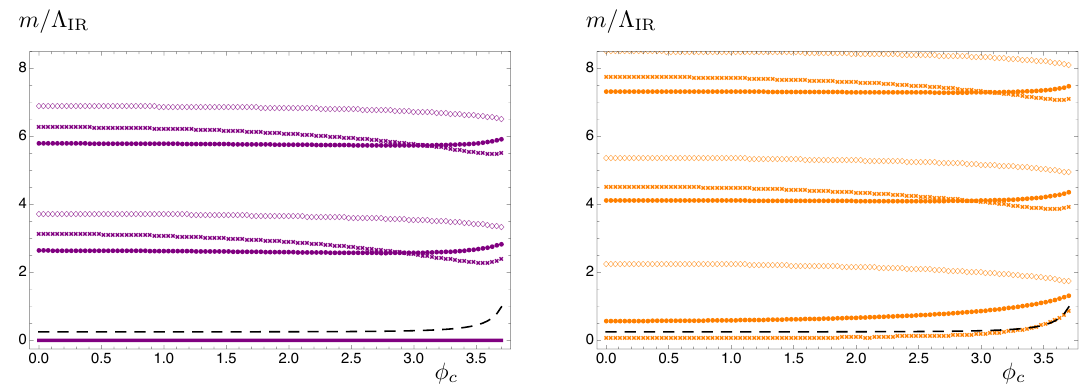
Figure 22 . Model II. Fermionic spectrum as a function of y 5 for ∆ = 3 , x F = 1 , g 5 = 8 , ∆ φ = 1 , φ c = 1 . 5 , ˜ λ 0 , IR = ˜ λ (max) , and ∆ R = 1 . 51 , 2 . 5 , 3 (diamonds, dots, crosses). The left and right panels 0 , IR correspond to imposing (+) and ( − ) IR boundary conditions, respectively. The solid line in the left panel indicates the presence of a massless state. The ratio between the UV and IR energy scales is equal to Λ UV = 10 3 . We used the IR regulator r 1 = 10 − 12 in the numerics. Λ IR